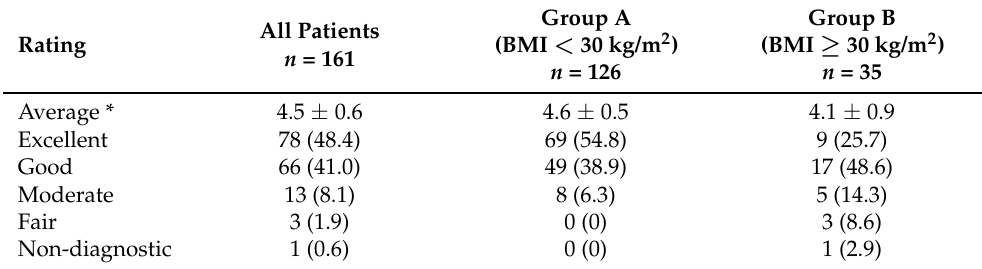
Table 4. Subjective image quality of the low-dose CTA